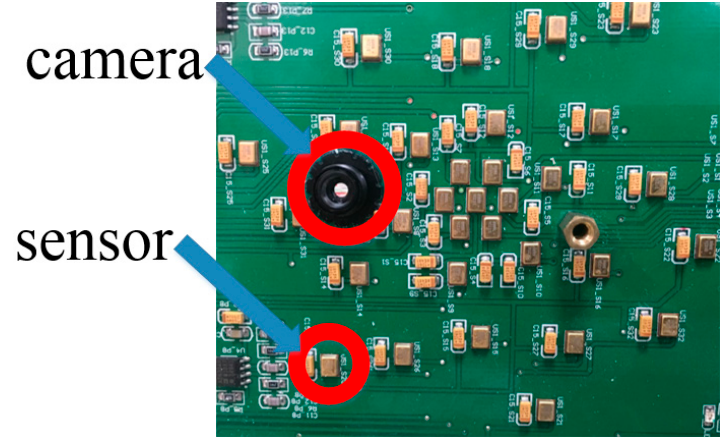
Figure 7. Picture sensor array printed circuit board (PCB) board.